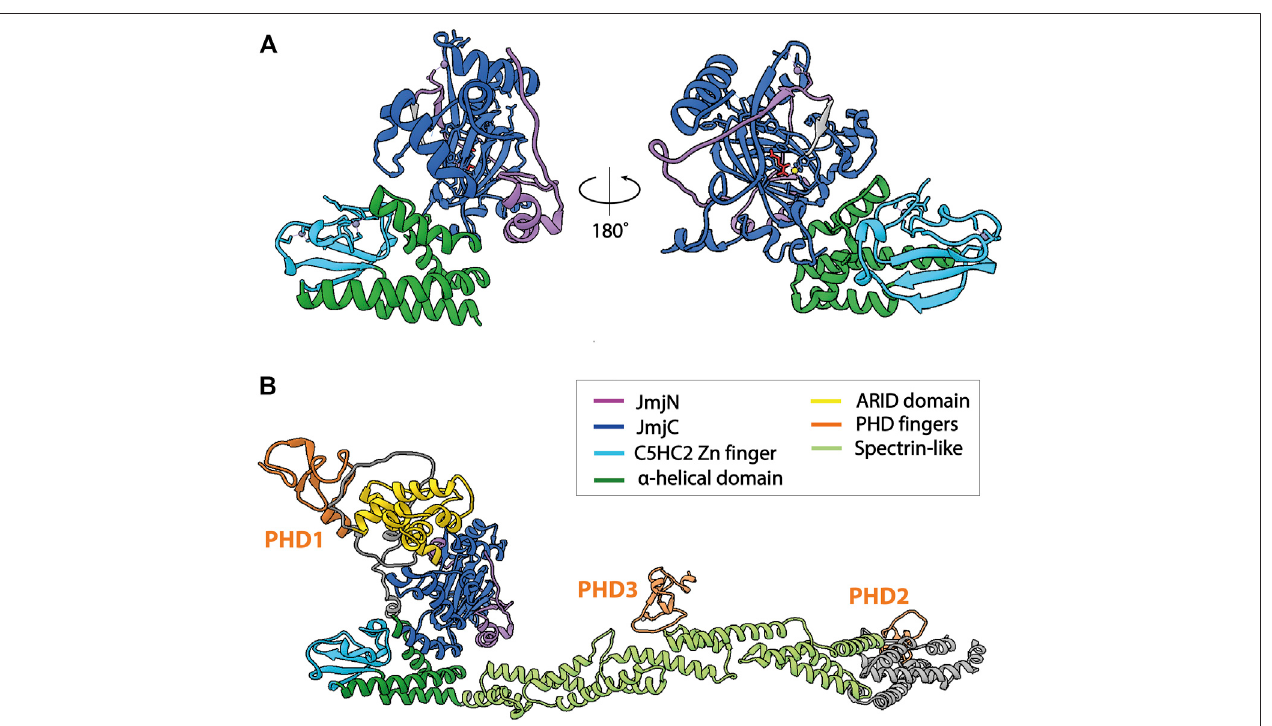
FIGURE 2 | Structures of KDM5B. The catalytic cores of KDM5 enzymes are structurally highly similar, therefore only structures of KDM5B are shown. (A) Atomic model of the catalytic core of KDM5B [PDB 5A1F (Johansson et al., 2016)]. The construct crystallized was composed of the JmjN and JmjC domains, as well as the α - helical domain including the C5HC2 Zn fi nger. The ARID and PHD1 domains were not included. The α -helical domain and the C5HC2 Zn- fi nger are required for demethylase activity, whereas the ARID and PHD1 domains are dispensable for the demethylation of peptide substrates by truncated KDM5s. (B) Alphafold2 prediction of full-length KDM5B (AF-Q9UGL1-F1), showing the predicted arrangement of the protein domains C-terminal of the catalytic core in an extended conformation, in agreement withexperimentaldata (Dorosz et al., 2019).Ofnote, other conformations cannot beexcluded due tothe fl exibility